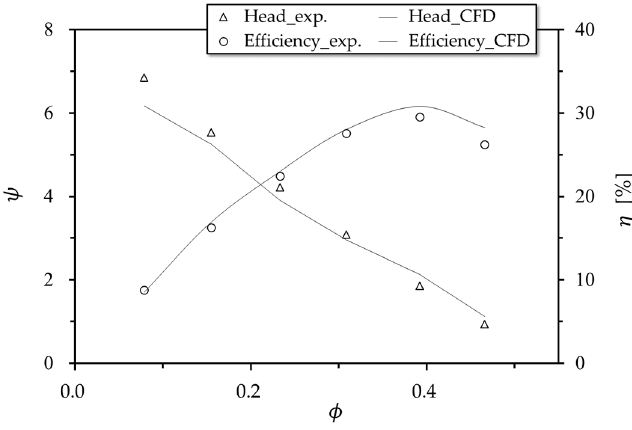
Figure 9. Comparisons of the reference pump performance.